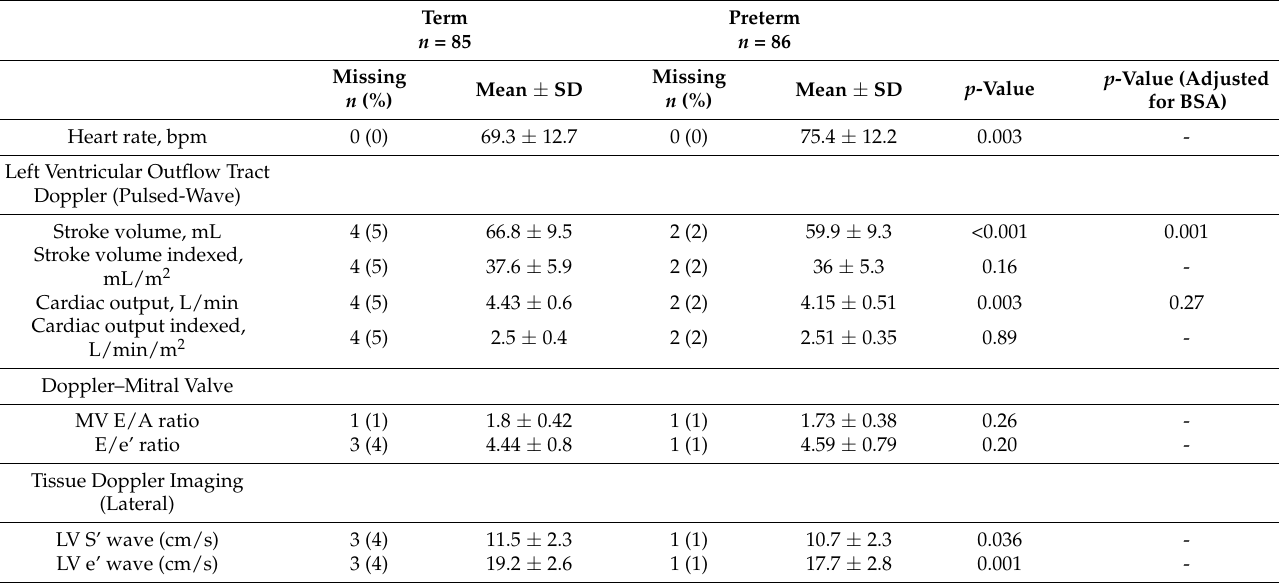
Table 3. Echocardiographic Markers of LV